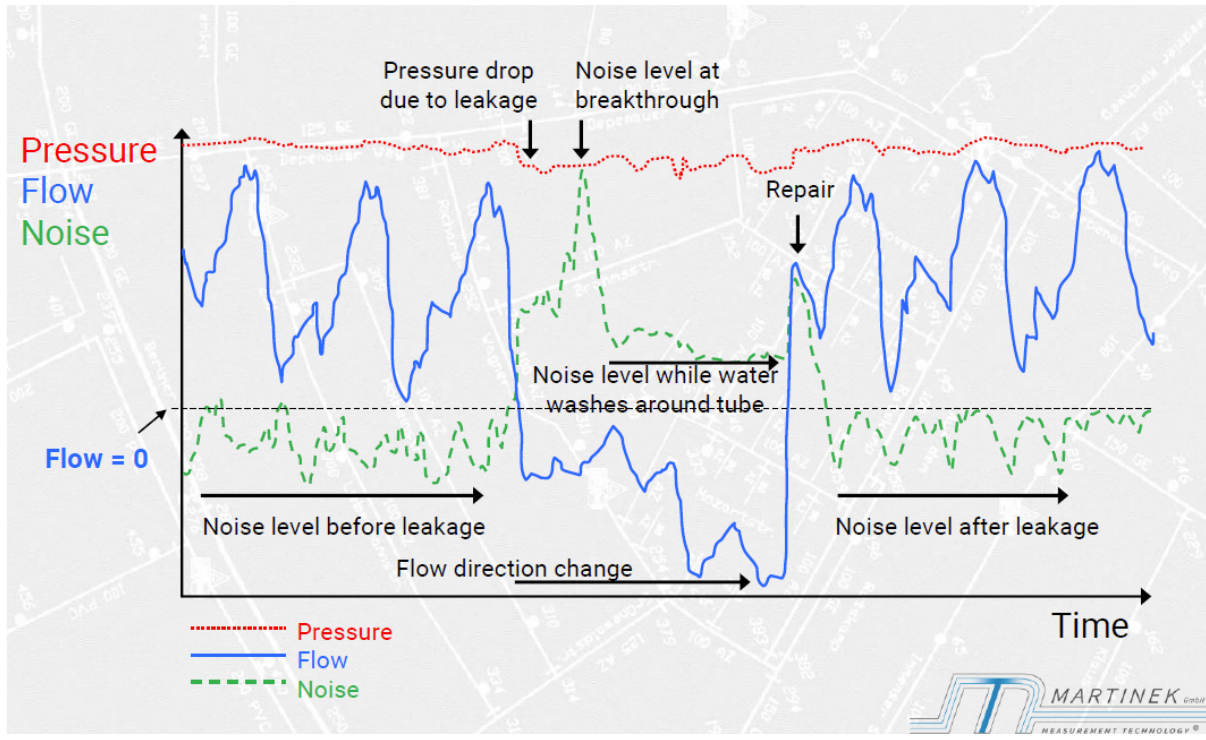
Figure 7: Variability of the tested parameters in the event of a leak – AQUALYS